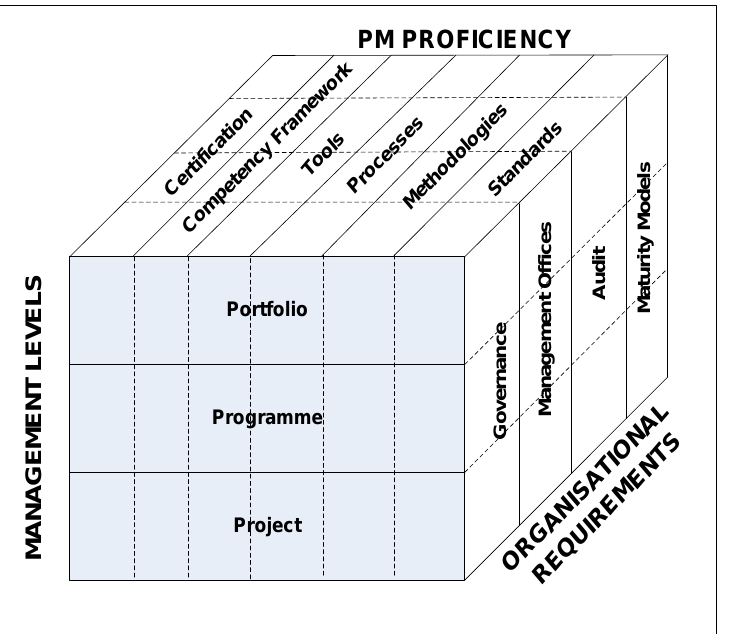
Figure 4. The Project Delivery Capability